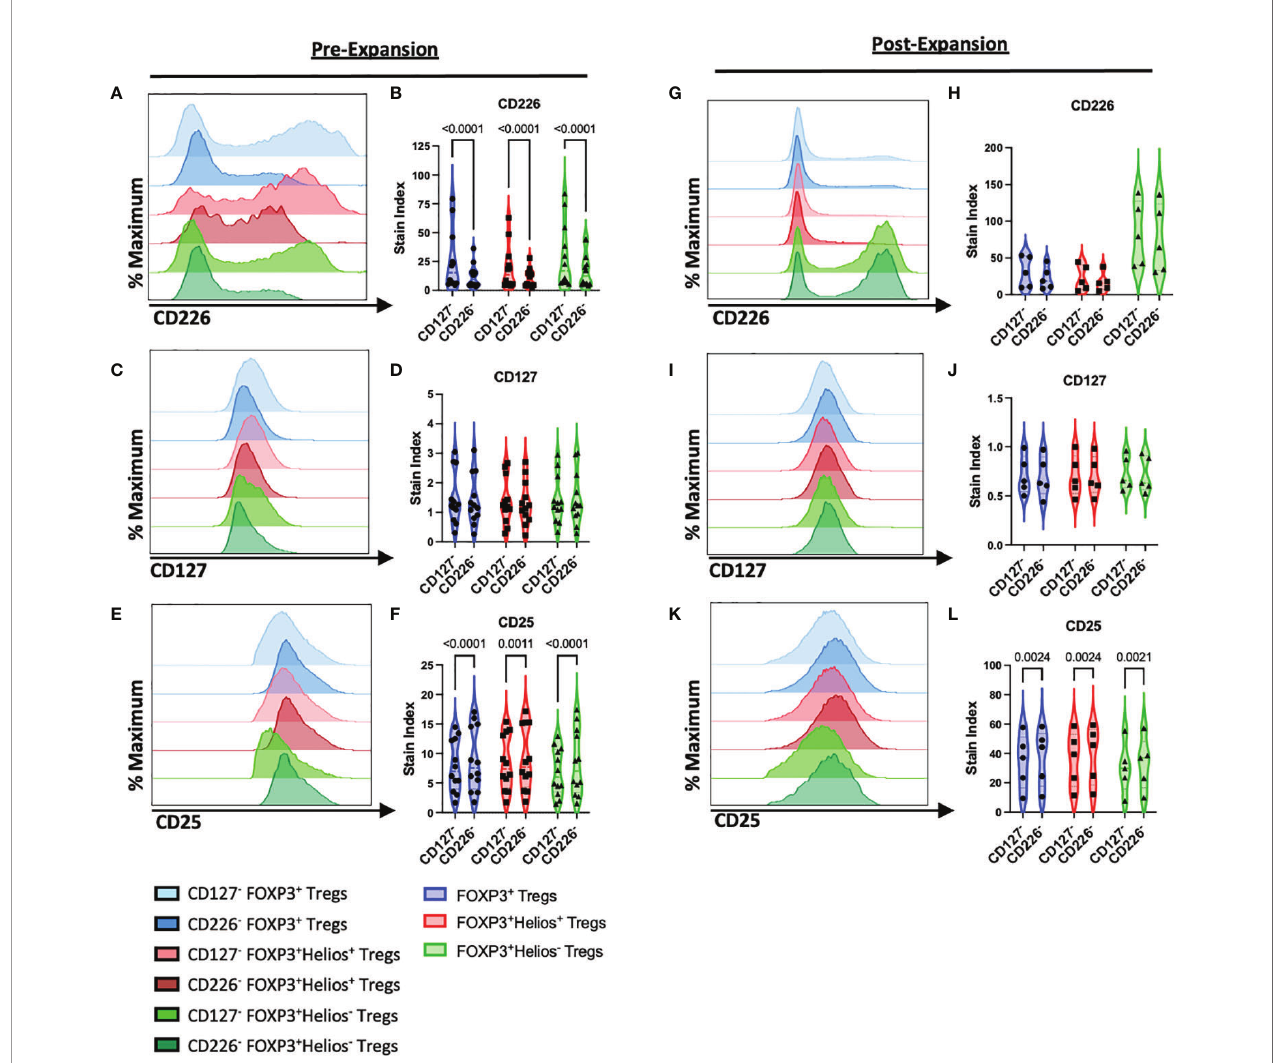
FIGURE 2 | CD4 + CD25 + CD226 - Tregs Exhibit Increased CD25 Expression. Representative histograms show expression of cell surface markers on CD127 lo/- (lighter blue) and CD226 - CD4 + CD25 + FOXP3 + Tregs (darker blue), CD127 lo/- (lighter red) and CD226 - CD4 + CD25 + FOXP3 + Helios + Tregs (darker red), and CD127 lo/- (lighter green) and CD226 - CD4 + CD25 + FOXP3 + Helios - Tregs (darker green) with violin plots showing stain index (SI) fold change from FMO controls, (A – F) prior to expansion ( n =12 biological with n = 2 technical replicates) and (G – L) following 14 days of ex vivo expansion ( n = 5 biological with n = 2 technical replicates). (A, B, G, H) CD226, (C, D, I, J) CD127, (E, F, K, L) CD25. Signi fi cant P-values are reported on the fi gure for two-way ANOVA with Bonferroni correction for multiple comparisons of Treg isolation conditions from matched